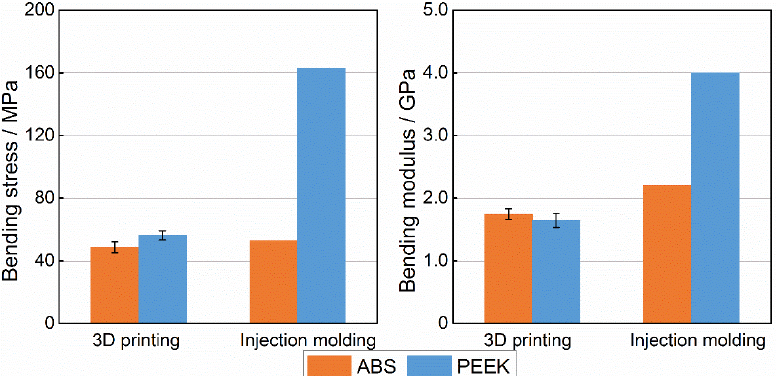
Figure 12. Comparison on bending property between acrylonitrile butadiene styrene (ABS) and polyether-ether-ketone (PEEK).